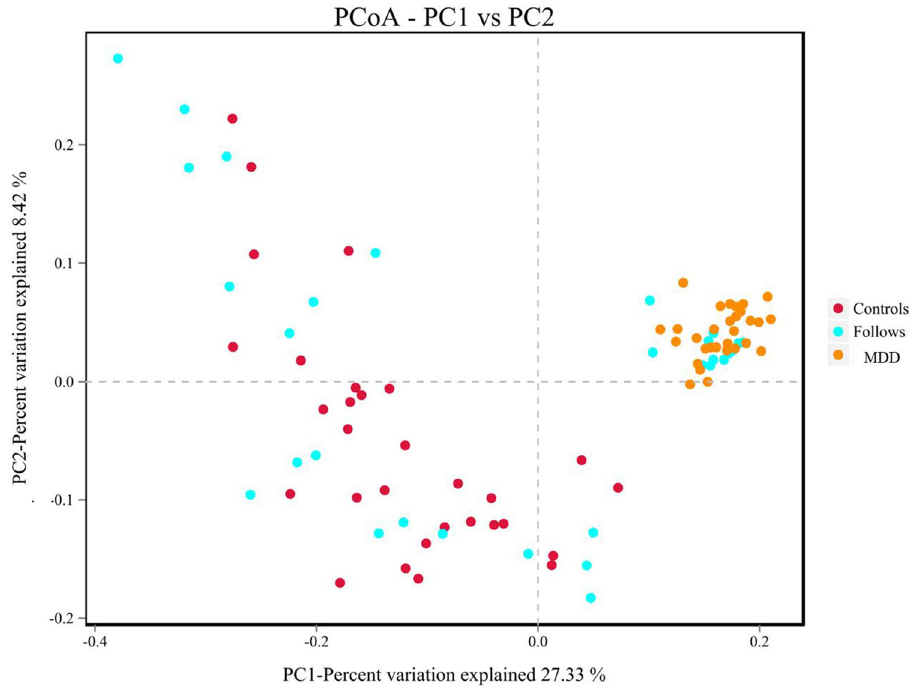
Figure 3. PCoA analysis shows the distribution coordinate diagram of samples: in the graph, the distance between the dots represents the similarity of the samples. Samples with high similarity tend to cluster together. The yellow dots represent the patient group, the blue dots represent the follow-up group, and the red dots represent the control group. The results showed a statistically significant difference among the three groups (R = 0.273, p =